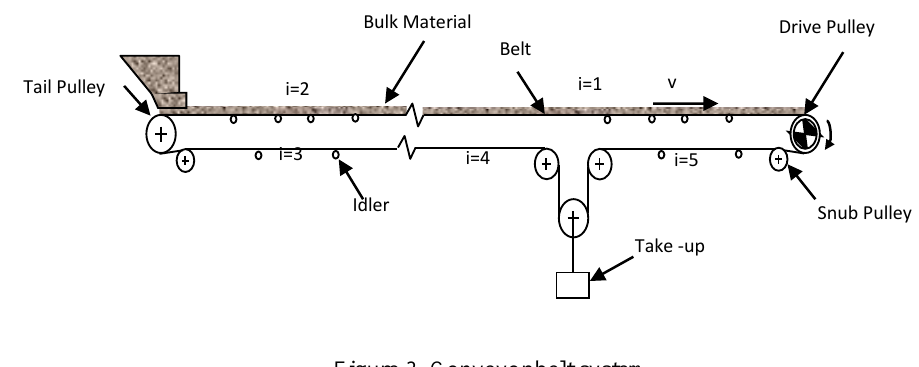
Figure 3. Conveyor belt